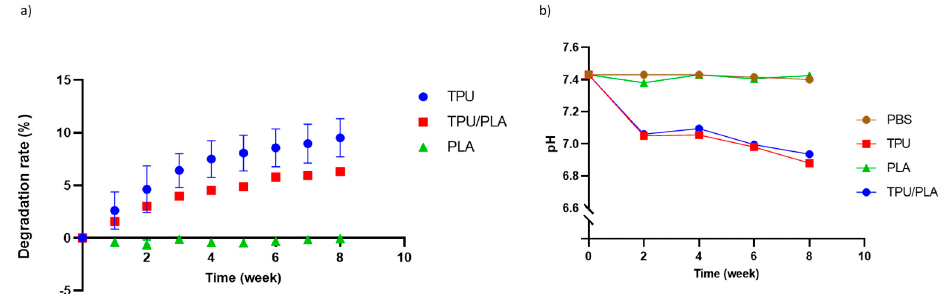
Figure 2. ( a ) The degradation rate of porous 3D-printed scaffolds. The TPU scaffold showed the highest degradation rate compared to other scaffolds. Moreover, the longer the time period, the higher the degradation rate. ( b ) pH analysis of the 3D printed scaffold extracts. The PLA extract showed no significant difference compared to PBS. However, in the first two weeks, a significant decrease in pH was observed in both the TPU and TPU/PLA extracts, which gradually reduced to below pH 7 after eight weeks.